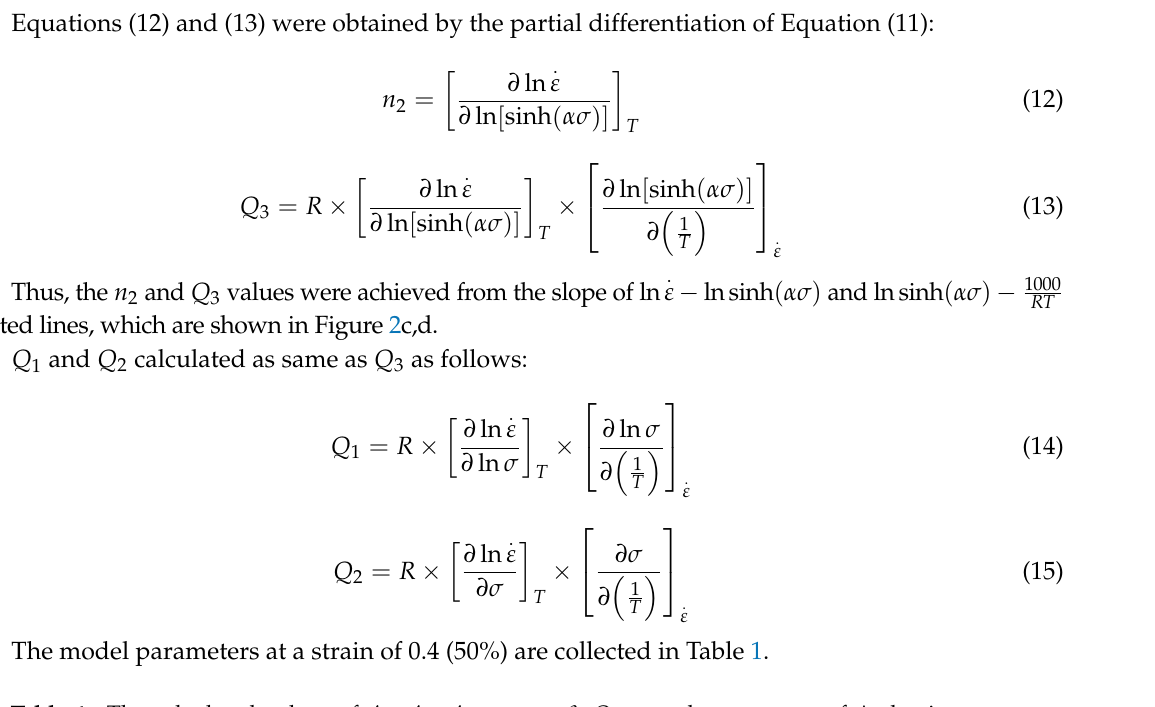
Table 1. The calculated values of A 1 , A 2 , A 3 , n 1 , n 2 , β , Q 1,2,3 and α constants of Arrhenius-type constitutive equation (ACE)